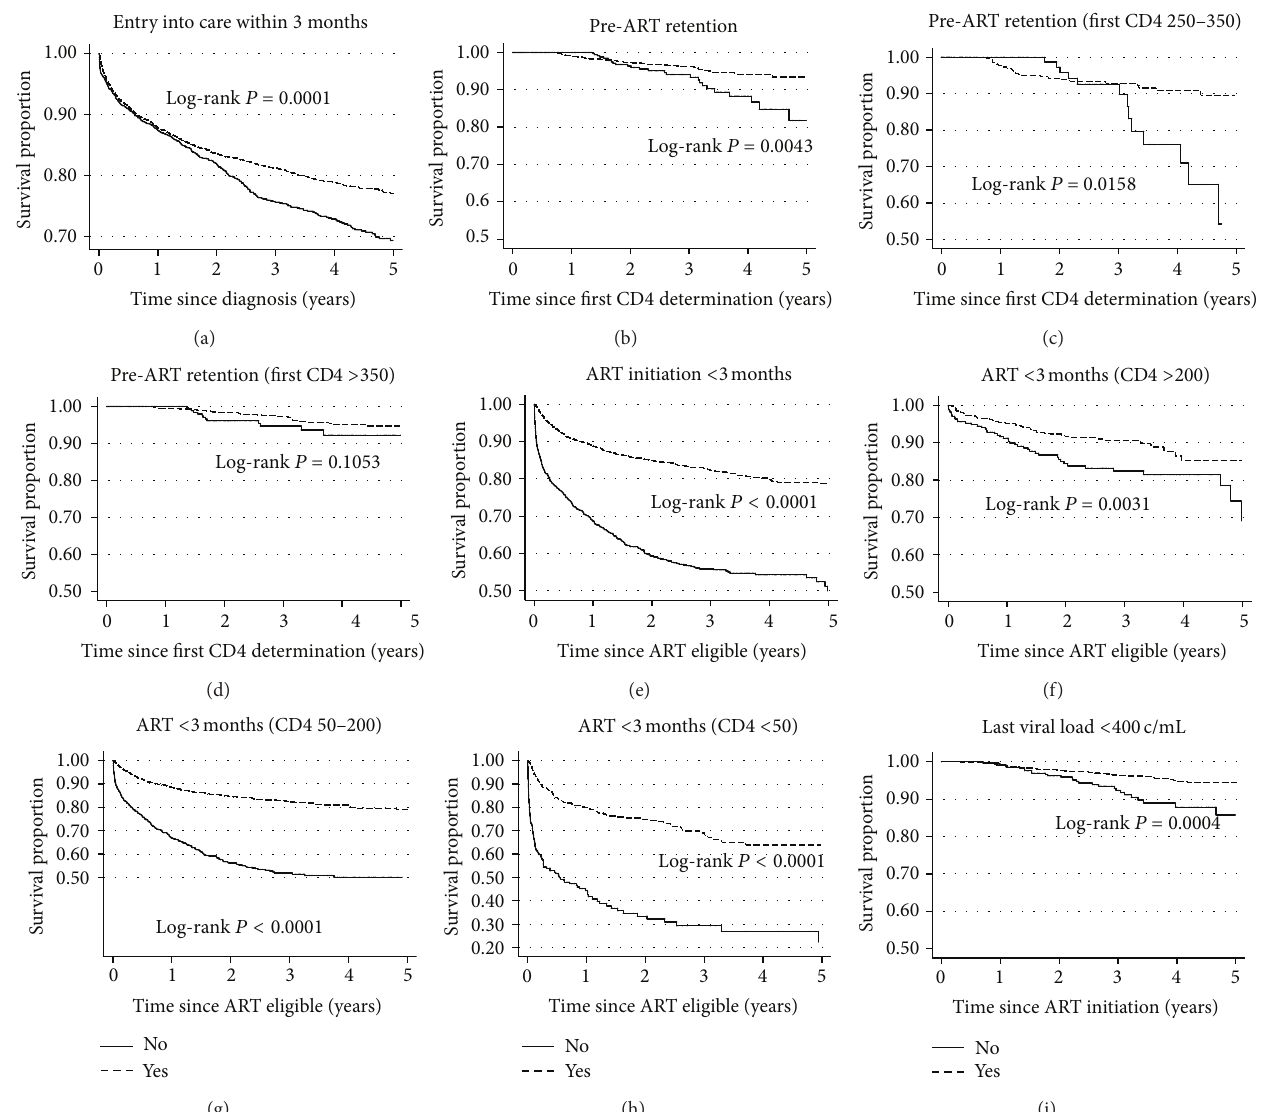
Figure 2: Survival curves at different stages of HIV care. Kaplan-Meier survival curves by entry into care within 3 months (a), by retention in pre-ART care (b), by retention in pre-ART care of patients with initial CD4 count 250–350 (c), > 350 (d), by ART initiation within 3 months of becoming eligible (e), by ART initiation within three months of patients with CD4 count > 200 (f), 50–200 (g), < 50 (h), and by virological suppression in the last viral load determination (i). ART, antiretroviral therapy; CD4, CD4 count in cells/ 𝜇 L; c/mL,